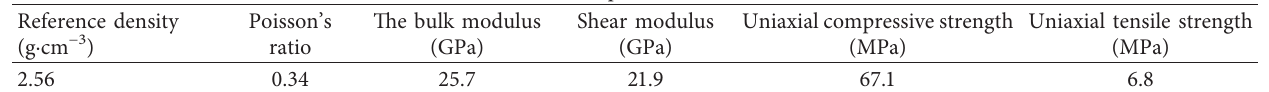
Table 3: Basic mechanical parameters of rock in the model.